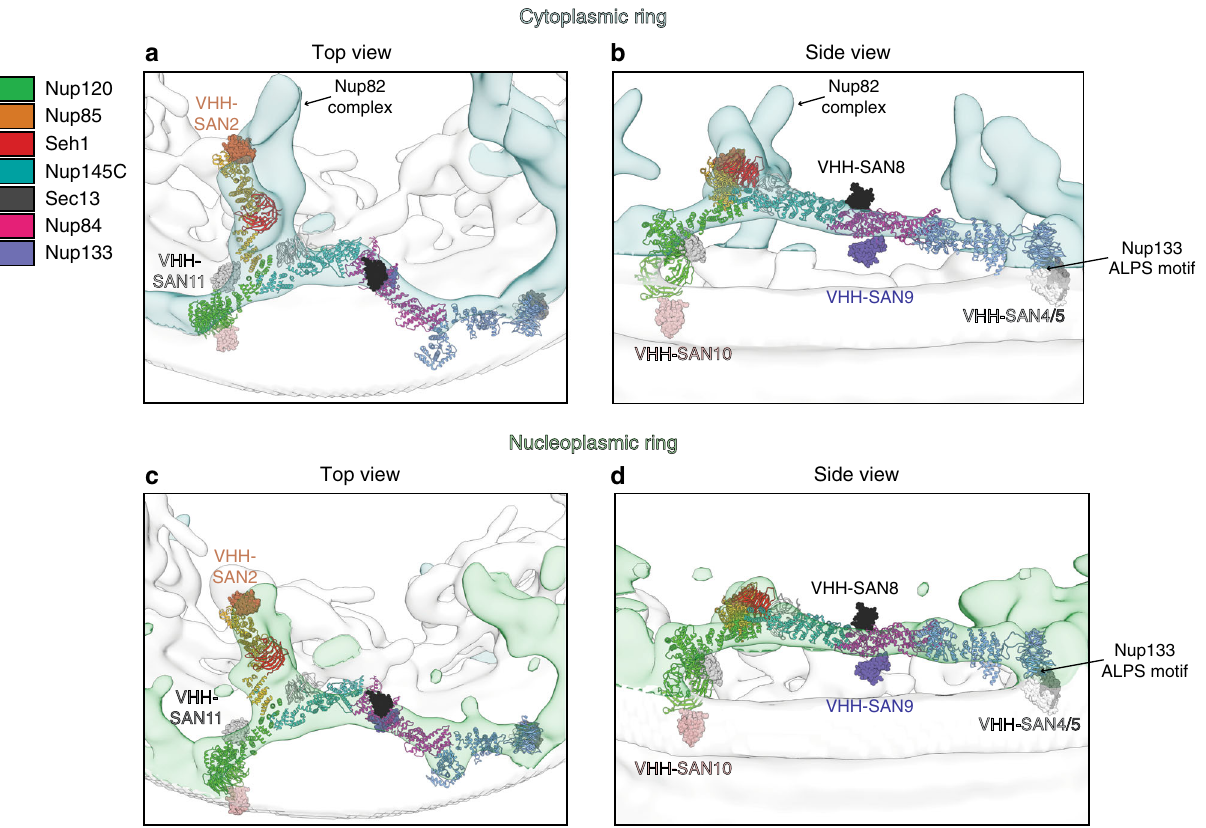
Fig. 7 Docking of the Y complex and nanobodies into the cryo-ET map of the NPC. a Top and b side view of the cryo-ET map from S. cerevisiae (EMD- 10198) with the density for corresponding to the cytoplasmic ring of the NPC colored in light blue. A top-scoring global fi t for the composite S. cerevisiae Y complex model shown in both a top and side view. Y complex nups colored as indicated in the legend (right). Nanobodies were not included during global fi tting, nanobody-nup complexes were superposed after docking. Nanobodies are shown with surface rendering and labeled with matching colors. Density corresponding to the Nup82 complex is indicated. The position of the Nup133 ALPS motif adjacent to the nuclear envelope is also indicated. c Top and d side view cryo-ET map with the density corresponding to the nucleoplasmic ring of the NPC colored in light green. Top-scoring global fi t for the composite S. cerevisiae Y complex model shown in both a top and side view. Nanobody positioning, coloring, and labeling as in a , b